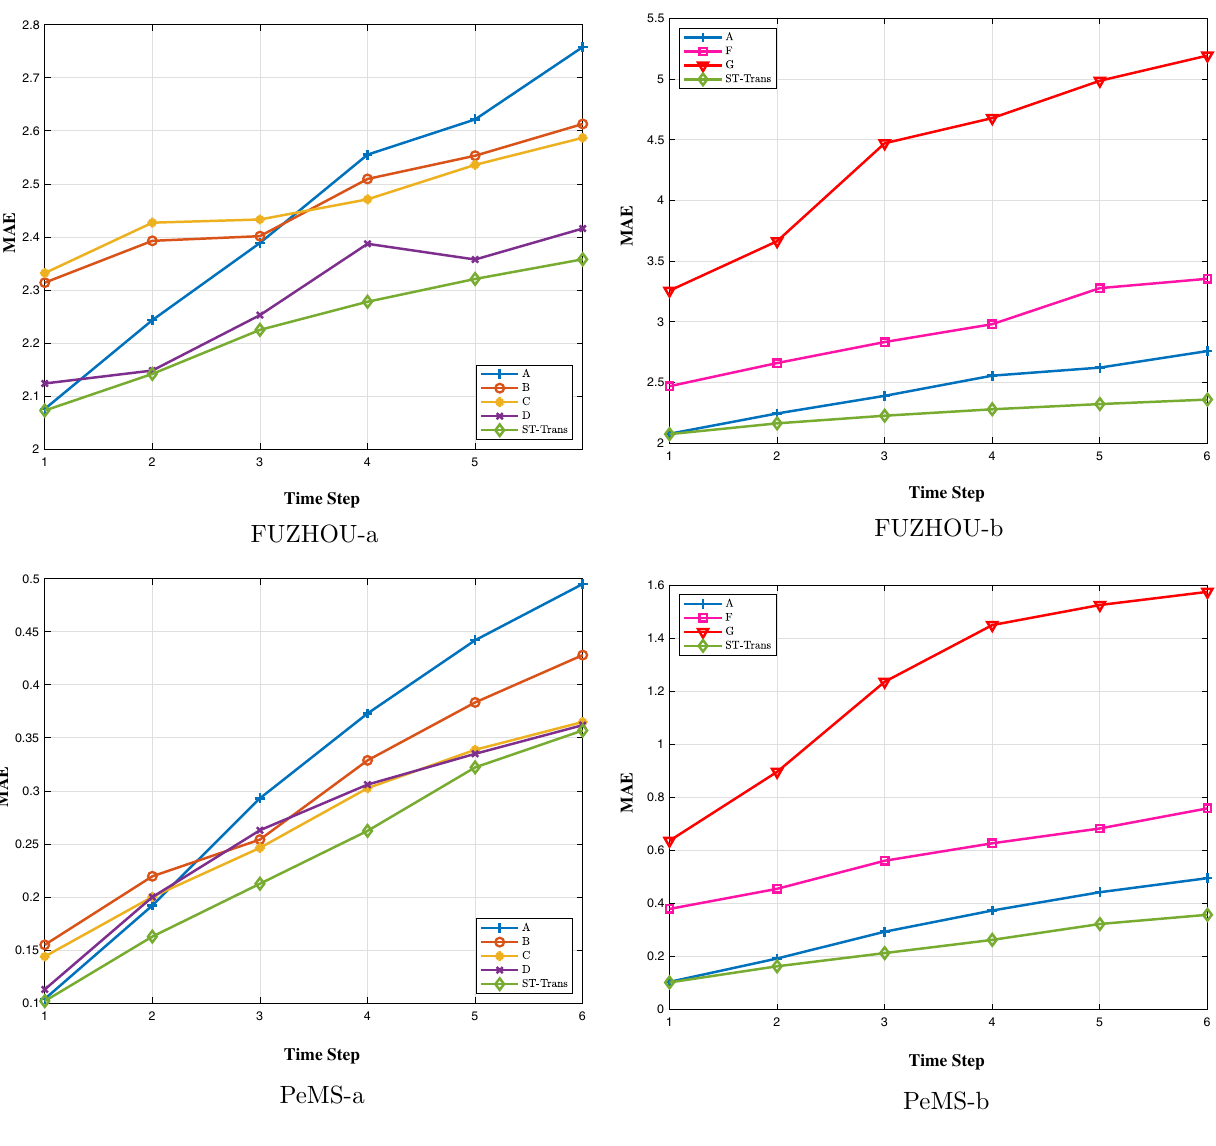
Fig. 8 Ablation experiments (display with